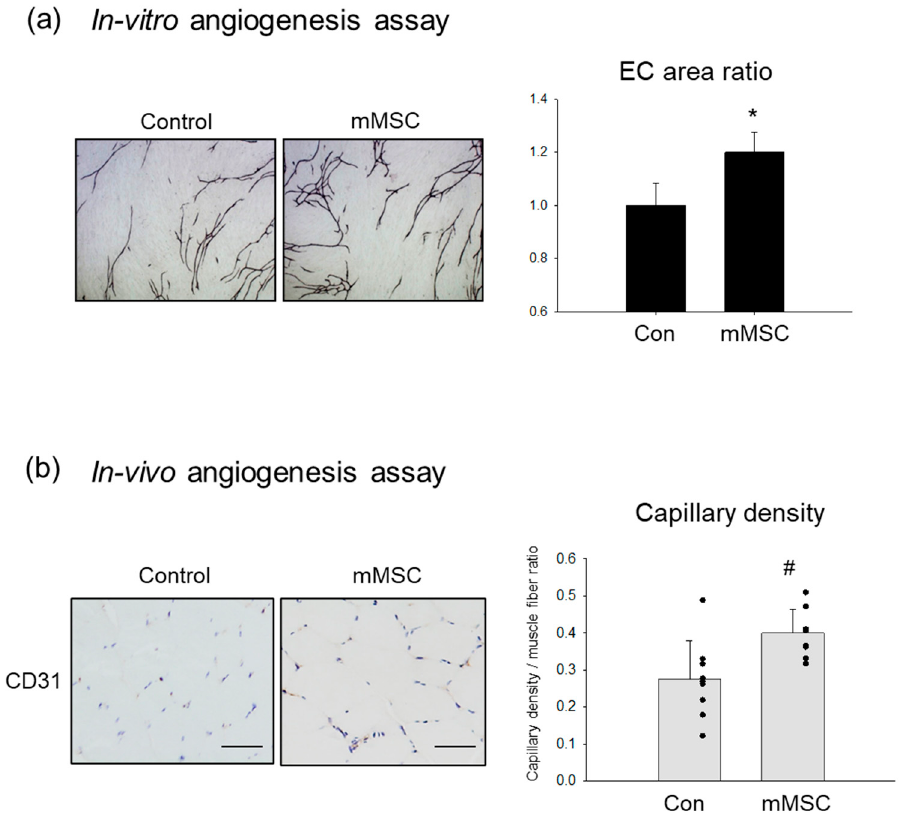
Figure 2. Angiogenic property of mMSCs in vitro and in vivo. ( a ) In vitro angiogenesis assay. Left, images of endothelial network immunostained with CD31 antibody. Original magnification × 40. Right graph, comparison of the areas of the endothelial tubule-like structures (EC area) between the control and conditioned medium from mMSCs. N = 4. * p < 0.05. ( b ) In vivo angiogenesis assay in a cell implantation model. Left, immunohistochemistry was performed using CD31 antibody to evaluate the capillaries in skeletal muscle on day 7. Right graph, comparison of the capillary density between the ischemic limbs treated with and without the mMSC implantation. N = 9. # p < 0.01. Bar = 50 µm.